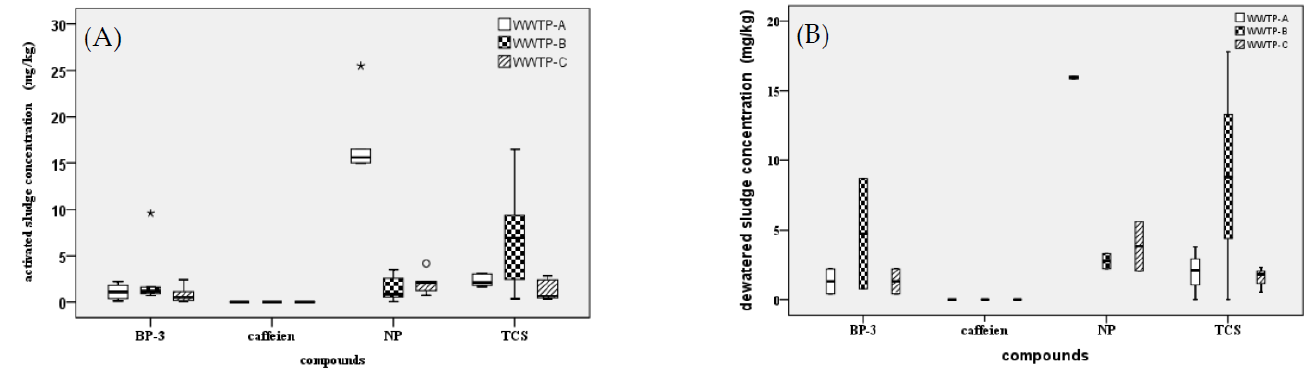
Figure 2. Target compounds in activated ( A ) and dewatered ( B ) sludges from three WWTPs. O represent outliers; * represent extreme values